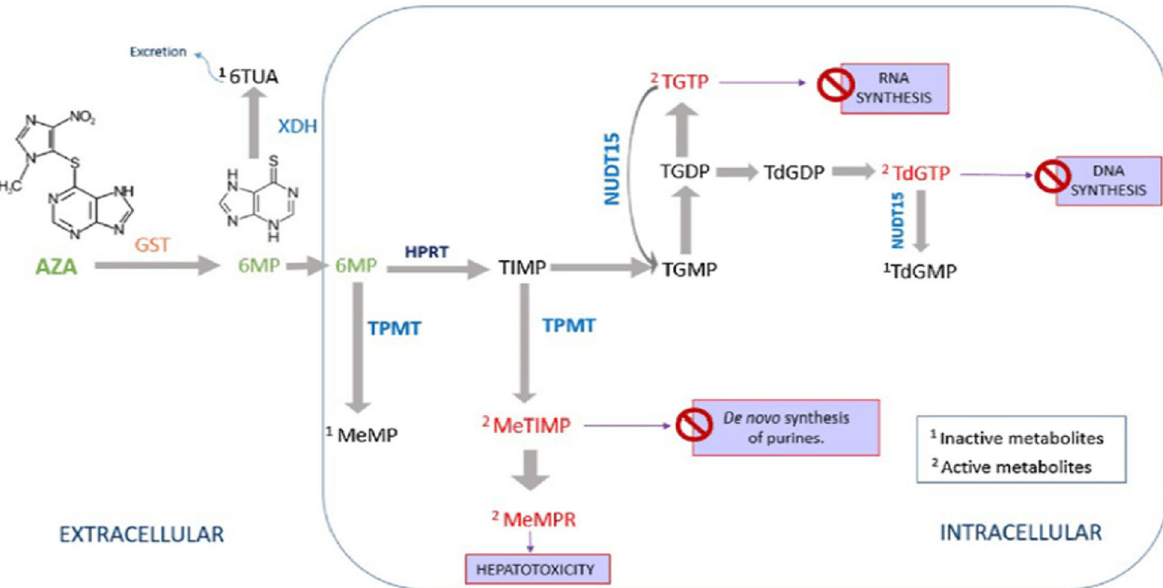
Fig. 1 AZA metabolic pathway mediated by TPMT and NUDT15. AZA azathioprine, GST glutathione‑Stransferase, 6‑MP 6‑mercaptopurine, XDH xanthine oxidase enzyme, 6TUA thiouric acid, HPRT hypoxanthine phosphoribosyltransferase, TIMP thioinosine monophosphate, TPMT thiopurine